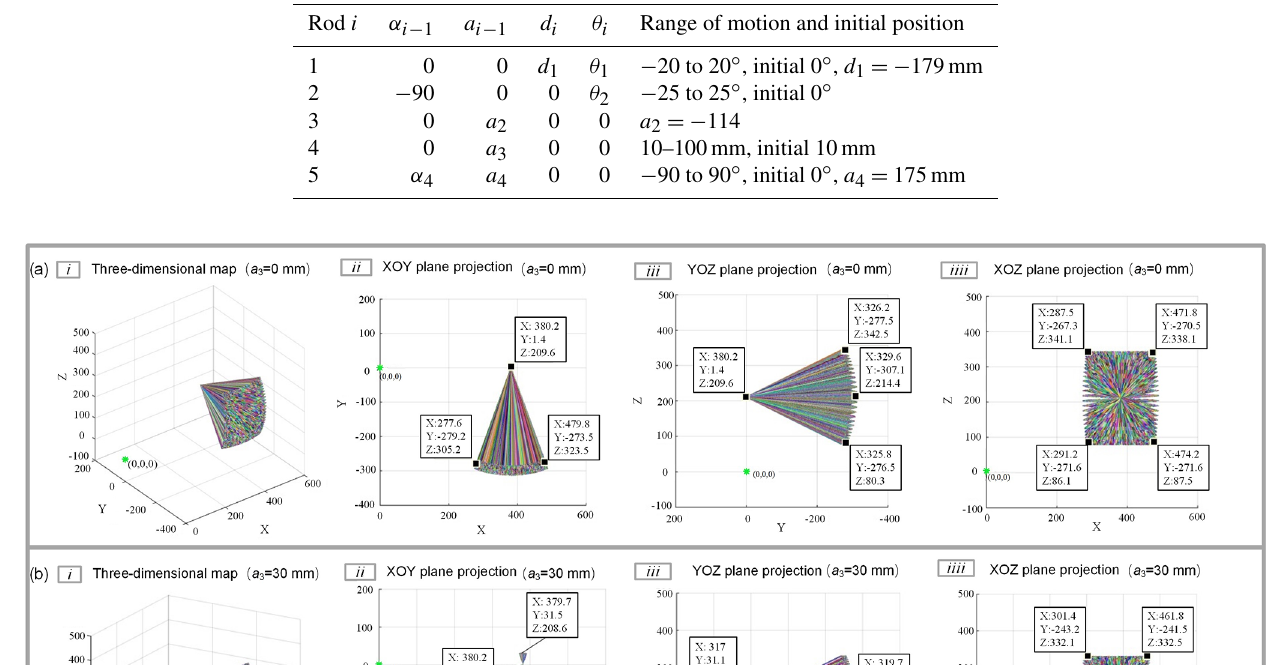
Table 1. D–H parameters of the manipulator.